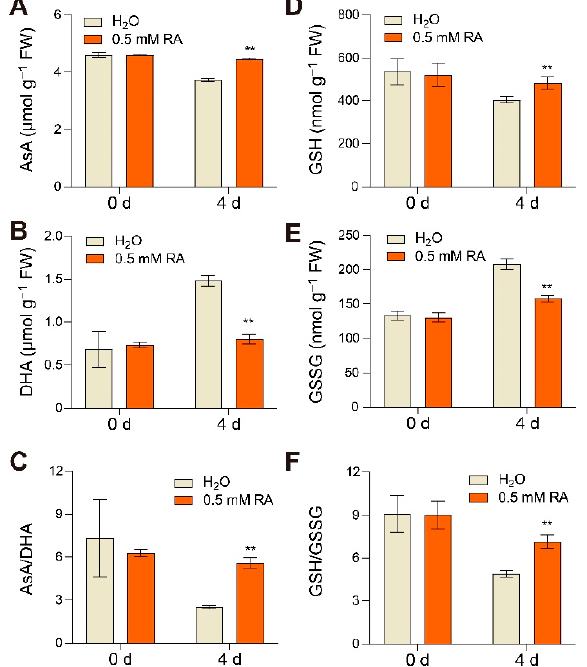
Figure 6. RA affected the redox status of antioxidant contents during fruit ripening. Effects of RA treatment on ( A ) reduced ascorbate (AsA) content, ( B ) dehydroascorbate (DHA) content, ( C ) redox status of ascorbate, ( D ) glutathione (GSH) content, ( E ) glutathione disulfide (GSSG) content, and ( F ) redox status of glutathione. Tomato fruits at the mature green stage were treated with 0.5 mM RA, or H 2 O control. The fruit samples were collected at the indicated time points for antioxidant quantification analysis. The data are presented as mean values ± SD; n = 4. Asterisks indicate statistically significant differences (** p ≤ 0.01) compared with control under the same time point, as determined by Student’s t -test.